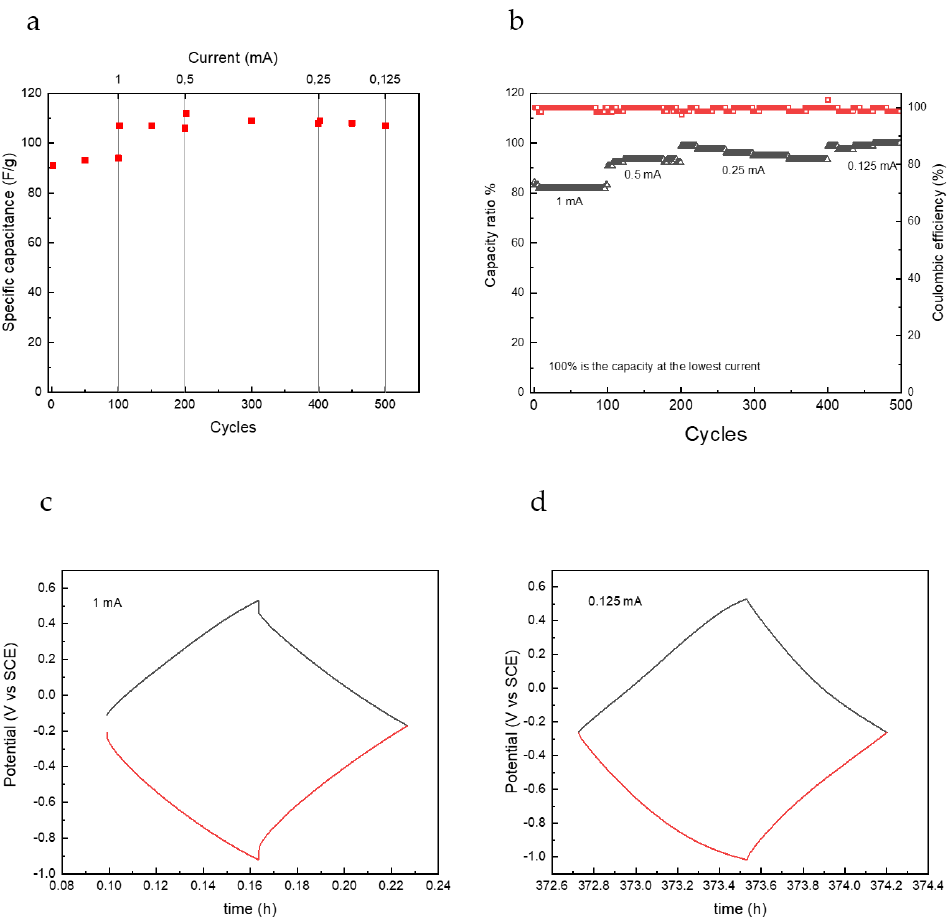
Figure 7. Performance of AC electrodes in AC//AC cell in Na 2 SO 4 1.5 M: ( a ) specific capacitance values, ( b ) coulombic efficiency and capacity ratio, voltage profiles of working electrode (black) and counter electrode (red) during galvanostatic charge and discharge cycles at ( c ) 1 mA and ( d ) 0.125 mA.